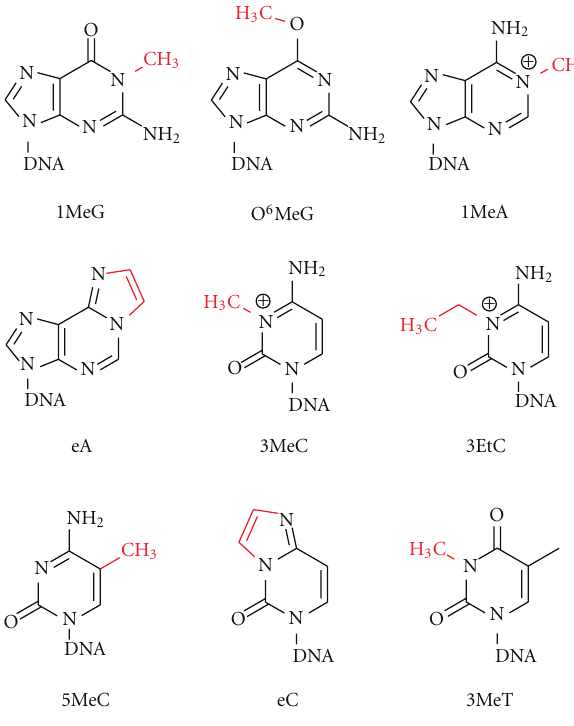
Figure 2: Chemical structures and abbreviations of DNA lesions screened as possible repair substrates for the AlkB protein using ESI-TOF mass spectrometry. The repair target within each base is highlighted in